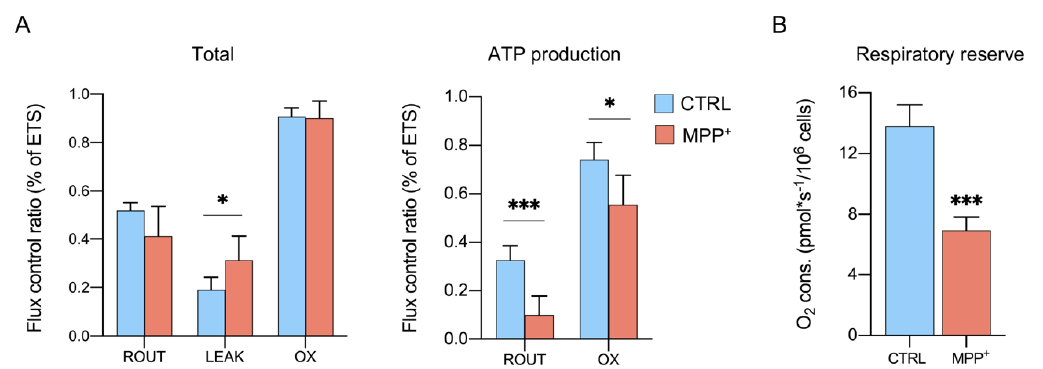
Figure 3. MPP + effect on mitochondrial respiration . ( A ) Oxygen consumption measured in different respiratory states in the presence or not of MPP + , expressed as the total or ATP-related flux. Data are displayed as the flux control ratio (FCR) of the maximal ETS capacity. ( B ) Oxygen flux related to the respiratory reserve of cells in the presence or not of MPP + . All data are shown as means with standard deviation; * p < 0.05 and *** p < 0.001.